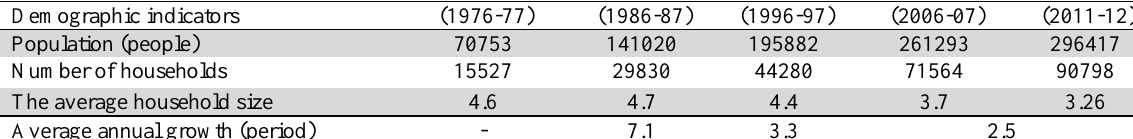
Demographic characteristics of sari city over the period 1976-2012 Demographic